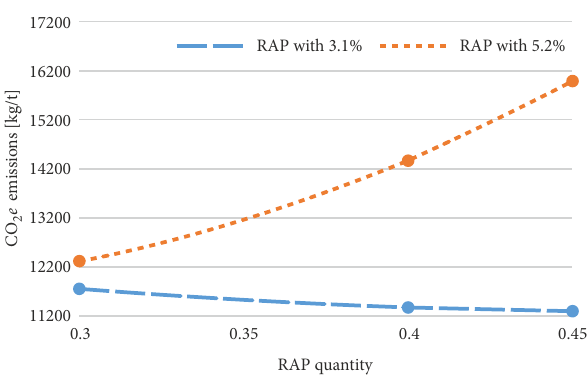
Figure 6. CO 2 e emissions with different RAP moisture and quantities calculated from experimental data Table 3. Natural gas consumption [m 3 ] for RAP